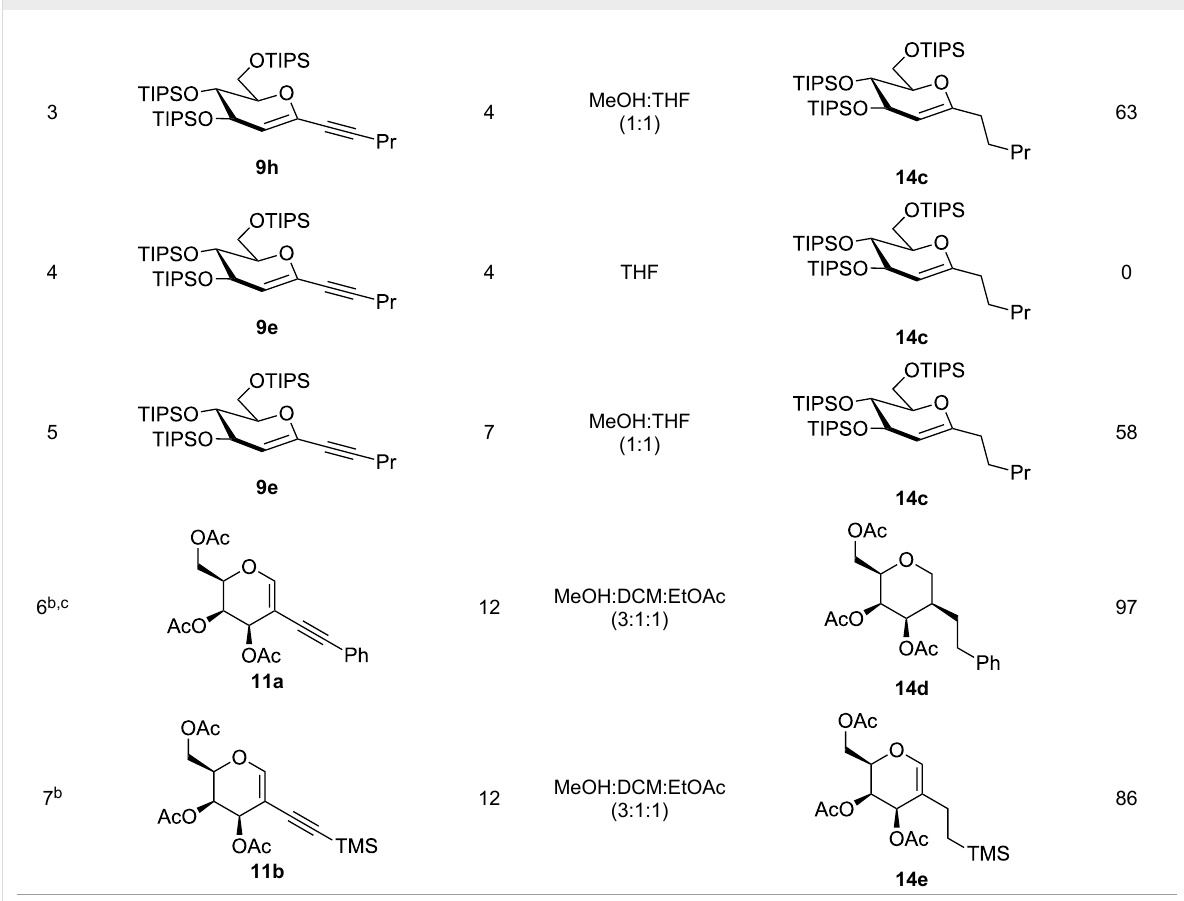
Table 3: Reduction of carbohydrate-derived enynes 9e – 9h and 11a – 11b .